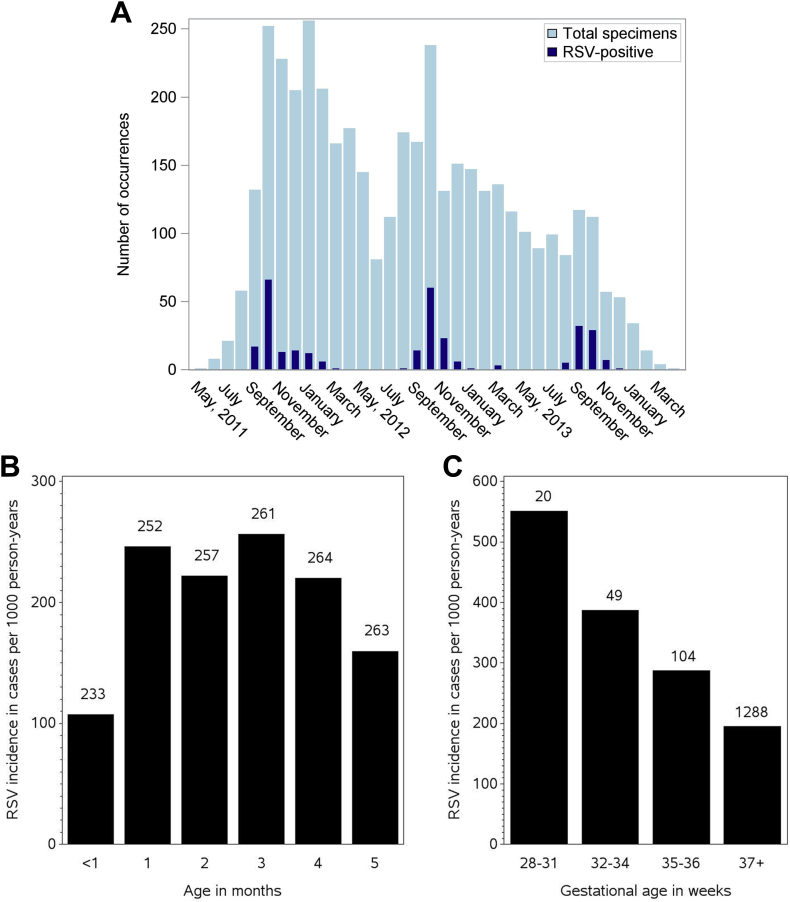
A. Seasonality of RSV over three seasons, from 2011 to 2014, in rural southern Nepal using active-home based surveillance. Overall incidence was 213/1000 person-years, while the incidence during RSV epidemic periods was 443/1000 person-years (by year, 2011–2012: 439/1000; 2012–2013: 407/1000; 2013–2014: 518/1000). B. Incidence based graph of RSV by age in months. The incidence of RSV ARI by age was lowest in the first month of life (107/1000 person-years) and higher in each of months two through five (246, 222, 256, and 220/1000 person-years, p < 0.001 for each), but not higher in month six (160/1000 person-years, p = 0.12). C. Incidence based graph of RSV by gestational age (very preterm: 28–31, preterm: 32–34, late-preterm: 35–36, term: >37). By gestational age, the incidence of RSV decreased from 551/1000 person-years in infants born between 28 and 31 weeks to 195/1000 person-years in infants born at 37 weeks or later (Fig. 2C, p = 0.017).